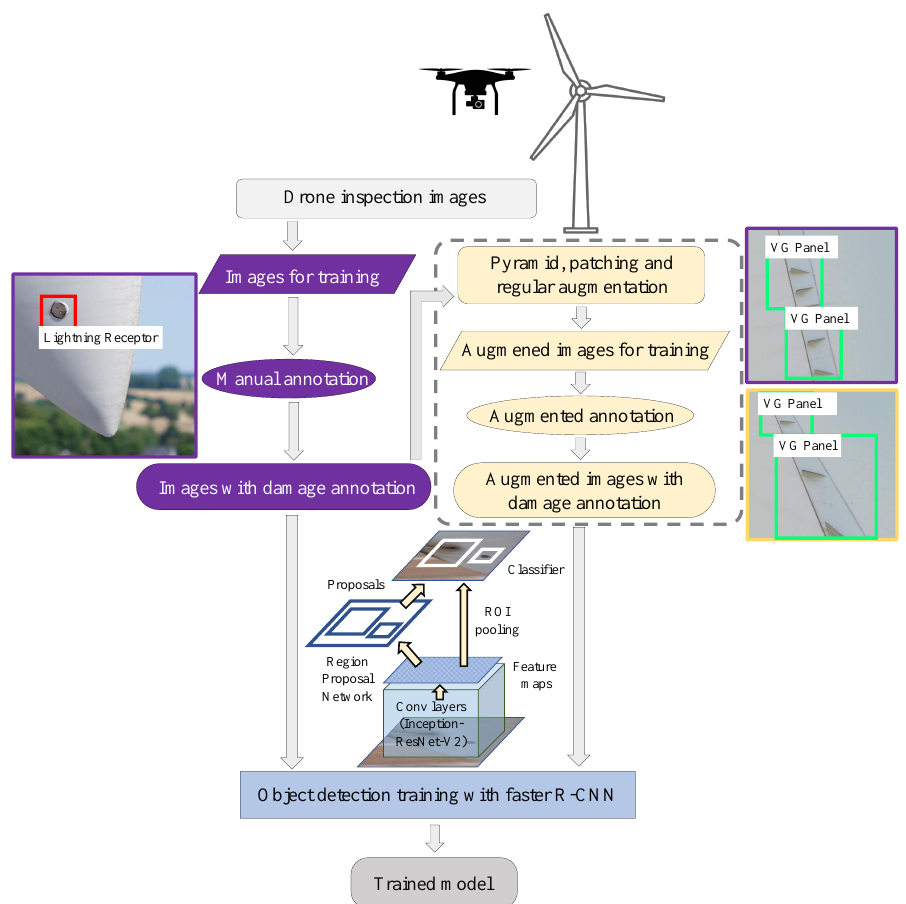
Figure 1. Flowchart of the proposed automated damage suggestion system. VG, Vortex